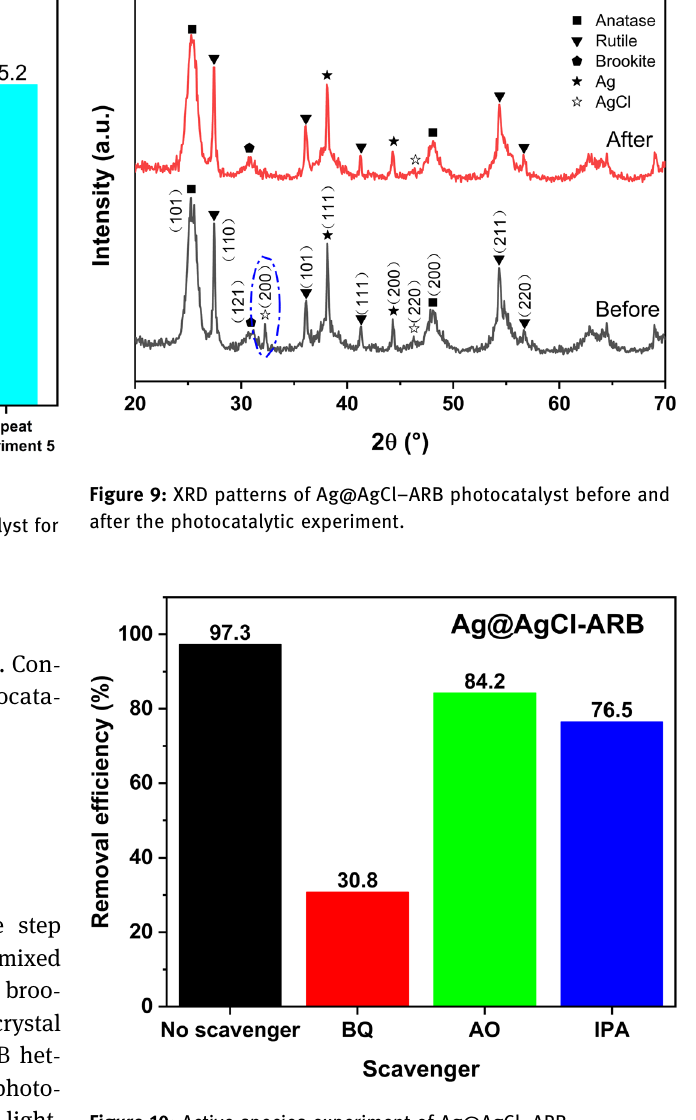
Figure 10: Active species experiment of Ag@AgCl – ARB.